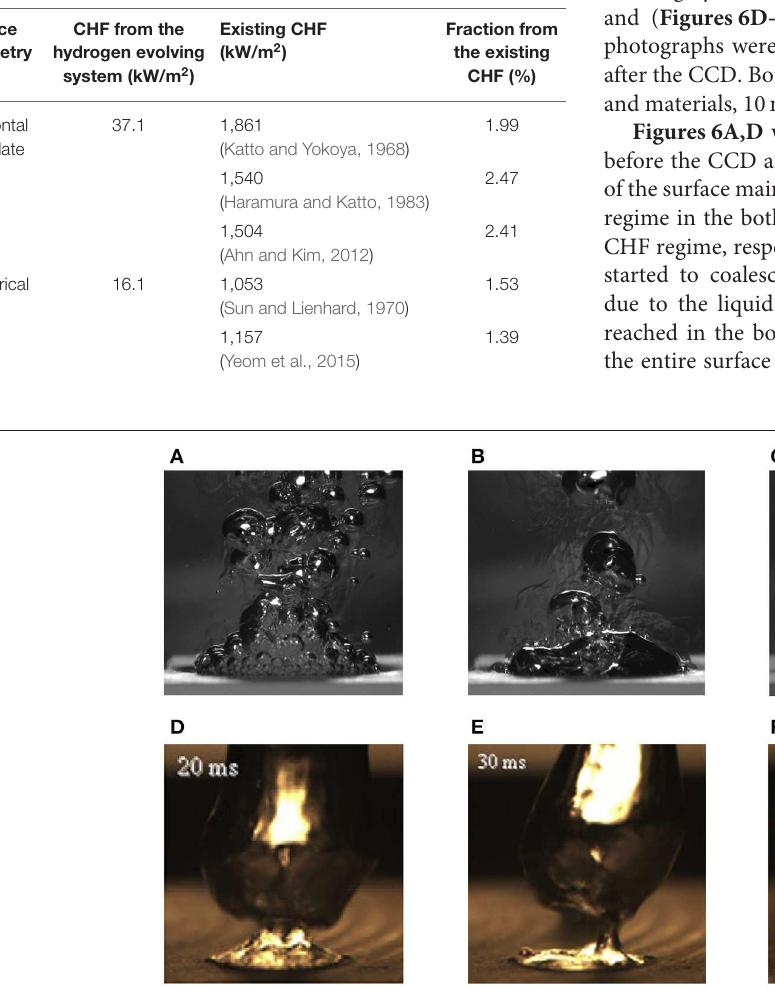
TABLE 1 | Comparison of the water CHF value between the present work and existing value.